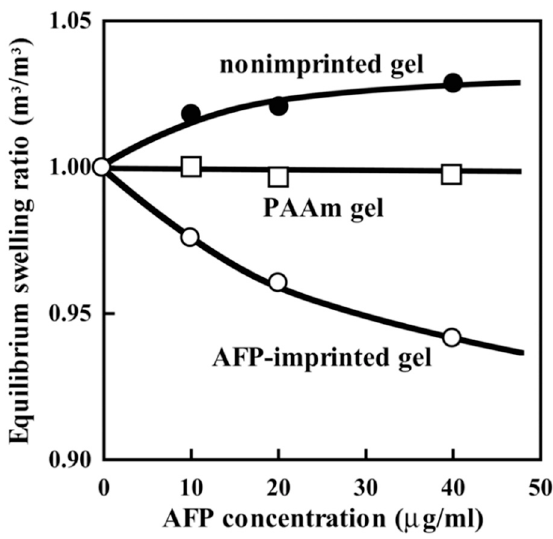
Figure 12. Swelling behavior of α -fetoprotein (AFP)-imprinted hydrogels in the presence of free AFP in solution [2] (Reproduced from [2] with permission. Copyright (2006) National Academy of Sciences.) PAAm: poly(acrylamide).